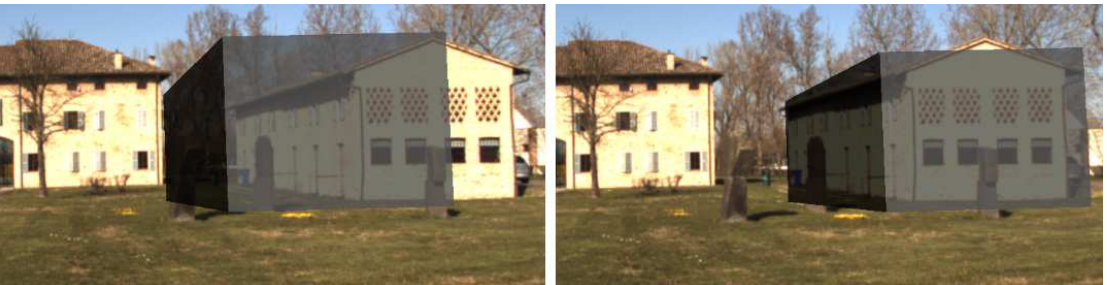
Figure 17. Building visualization in augmented reality: result from coarse registration (left) and after manual correction